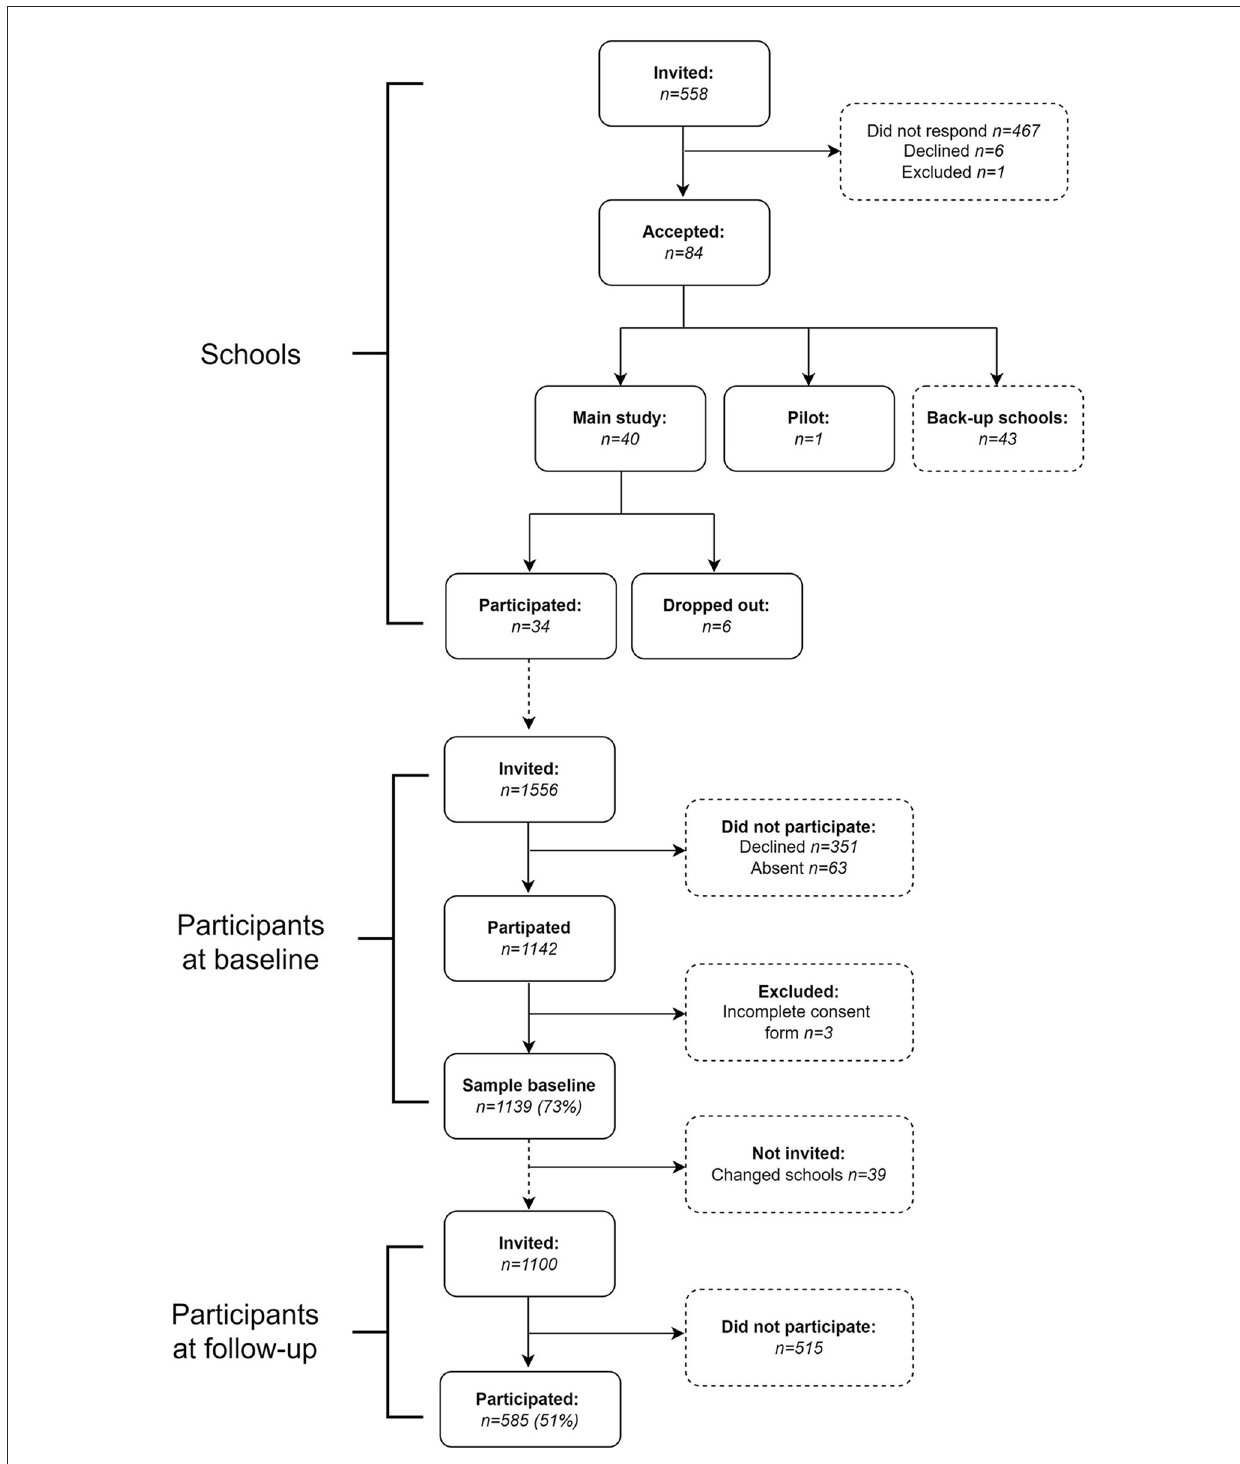
FIGURE1 Flow-chart of the schools and participants in the study.